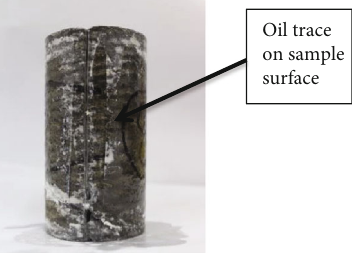
Figure 13: Oil-stained sample.